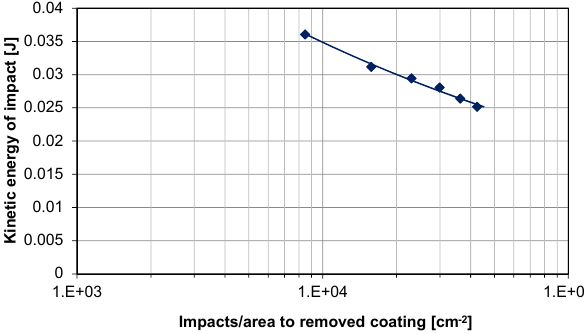
Figure 4. Rain erosion test data plotted as a Wöhler curve: impacts per unit area to failure as a function of the kinetic energy for each